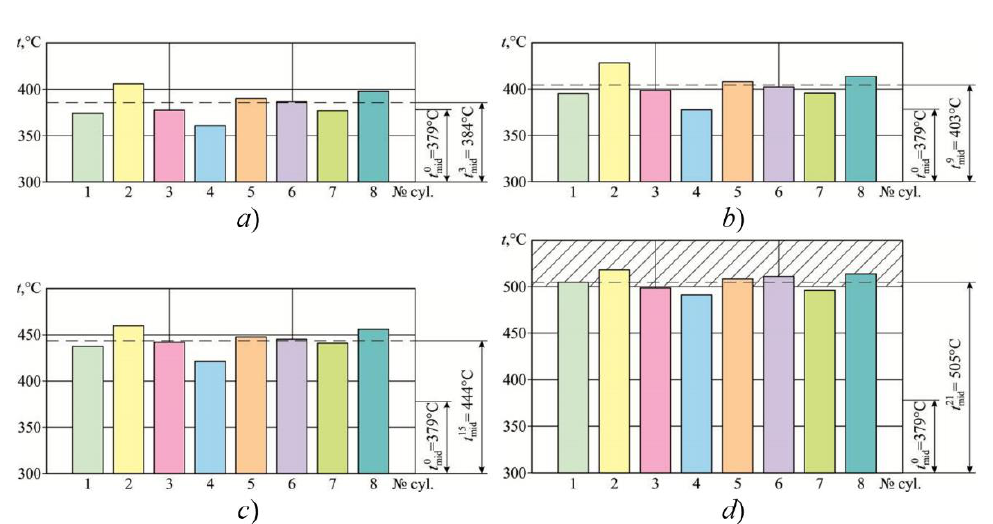
Figure 11. Change in exhaust gas temperature in the cylinders of a 16V32 STX-MAN marine diesel engine at different values of the degree of exhaust gas recirculation (load 35%): ( a ) δ EGR = 3%; ( b ) δ EGR = 9%; ( c ) δ EGR = 15%; ( d ) δ EGR = 21%.